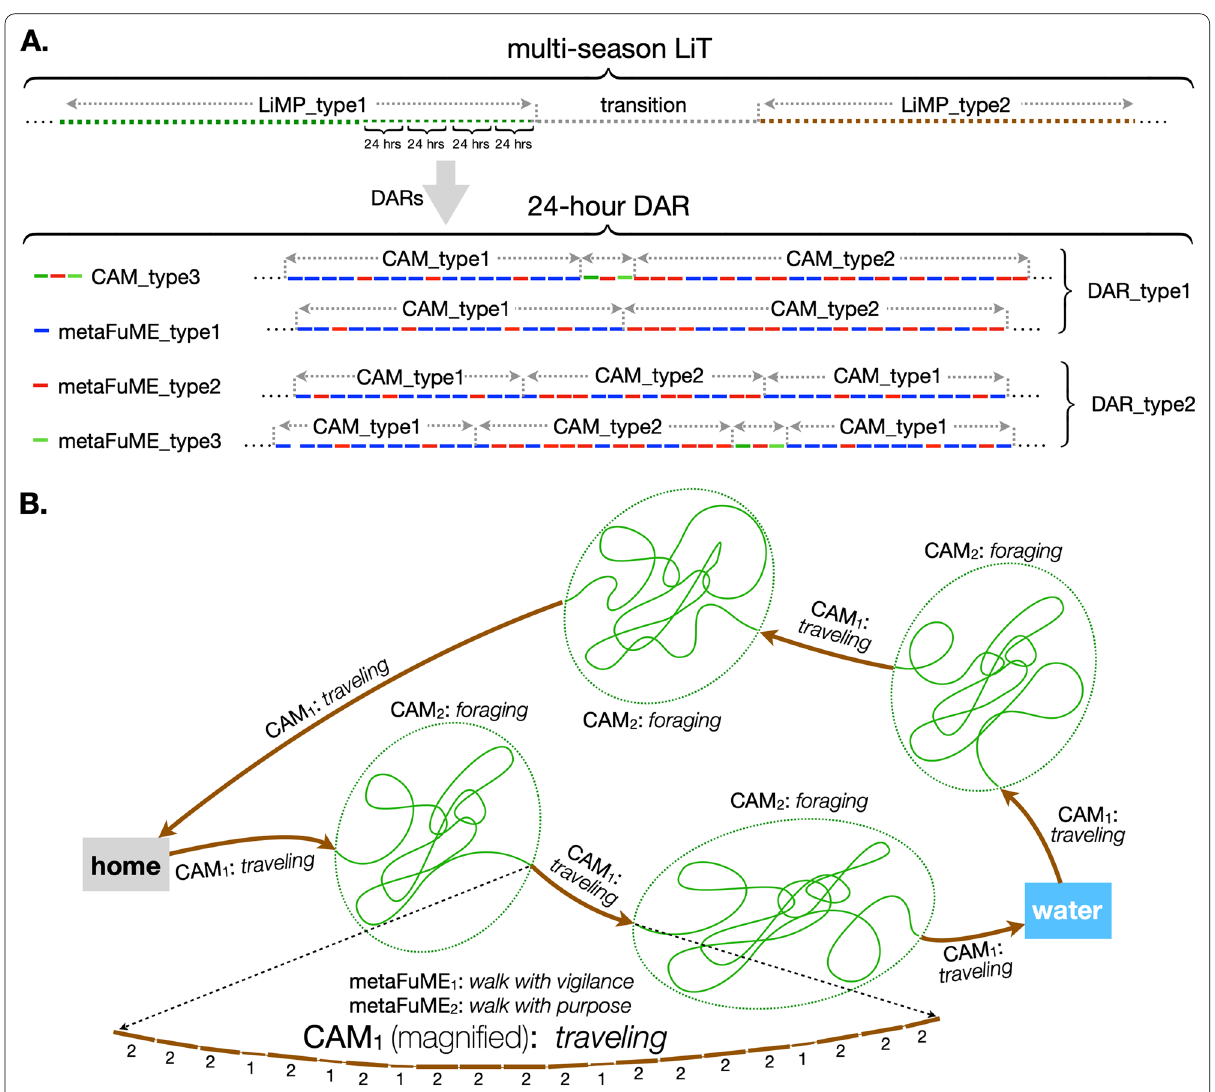
Fig. 3 The segment structure of movement paths at different scales according to the scheme proposed in Fig. 1. A A multi-season lifetime track (LiT) W (Eq. 1) can be segmented into different types of lifetime movement phases (LiMPs), each of which can then be segmented into diel activity routines (DARs) and again segmented into canonical activity modes (CAMs). Each CAM is constructed from different proportions of metaFuMEs (aggregates of correlated fundamental movement elements), where each metaFuME is derived from a bivariate step-length/turning-angle distribution derived from time series with specific first-order correlative statistics. Short-duration CAMs (e.g., CAM 3) can easily be missed and averaged into longer duration CAMs (e.g., CAMs 1 and 2), if DAR segmentation analyses are not undertaken at a sufficiently fine scale. B An illustrative example of a simple two-CAM return-to-home-with-a-water-stop DAR where the two types of metaFuMEs that generate the traveling CAM are shown under